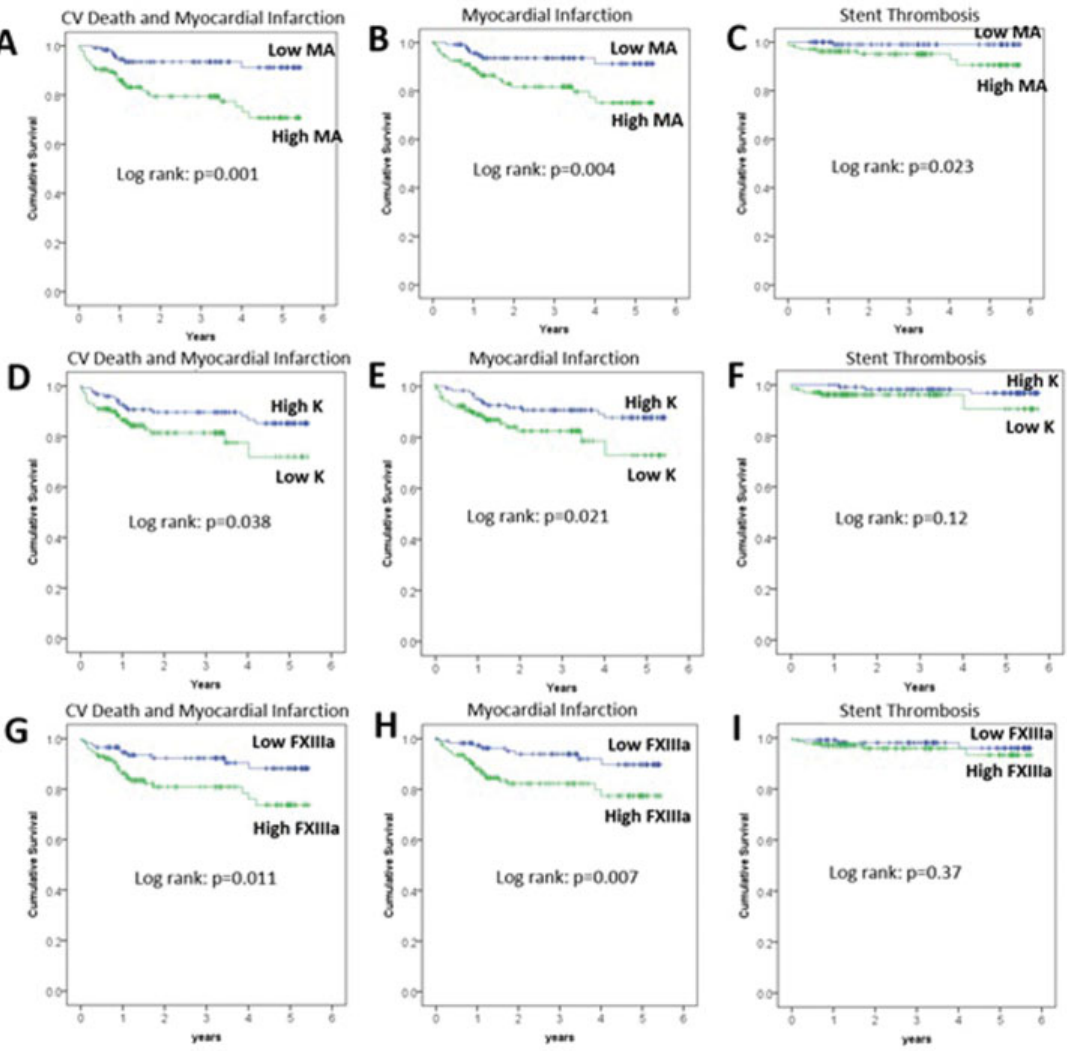
Fig. 2 Kaplan – Meier survival analysis according to high ( (cid:2) 35.35 mm) versus low TEG-MA ( < 35.35 mm) ( A – C ), high ( (cid:2) 1.15 min) versus low TEG-K ( > 1.15 min) ( D – F ), and high ( (cid:2) 83.51%) versus lowFXIIIa ( < 83.51%) ( G – I ) for primary endpointsof CVDorMI, MI ( C ),and possible/probable/de fi nitestent thrombosis.